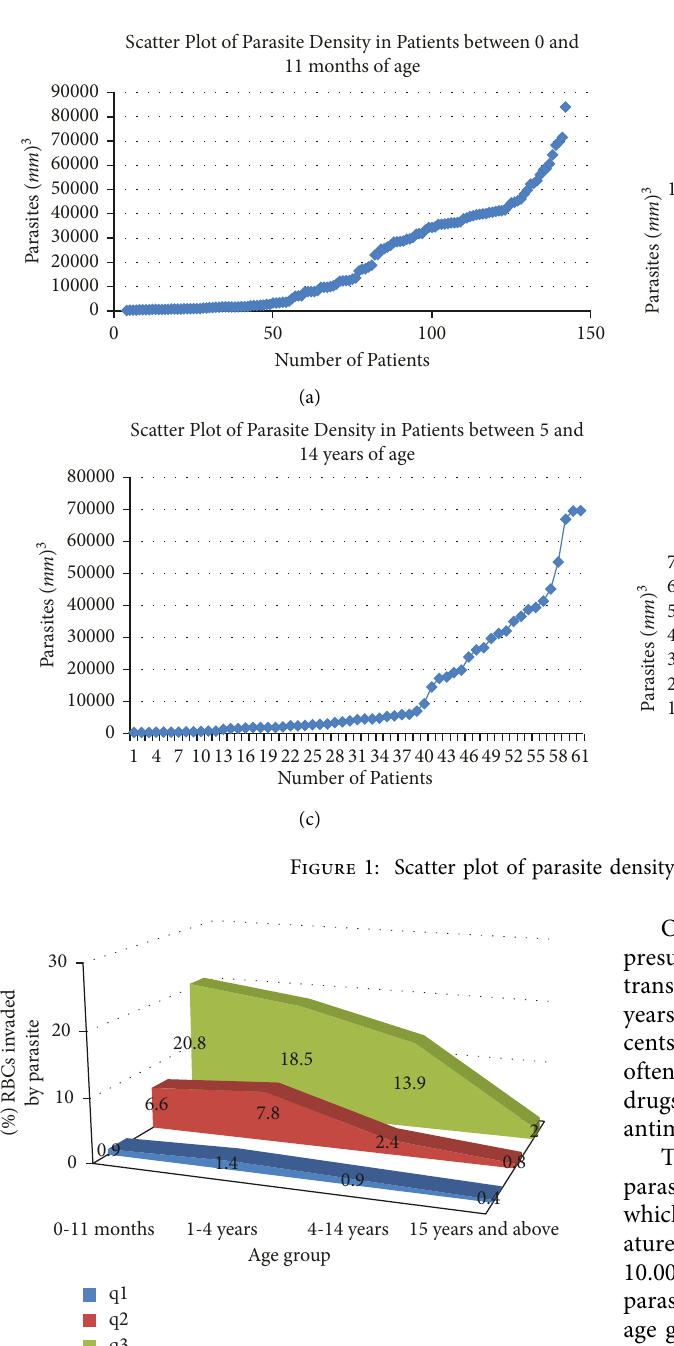
Figure 2: Distribution of parasite density in the percentage of red blood cells.